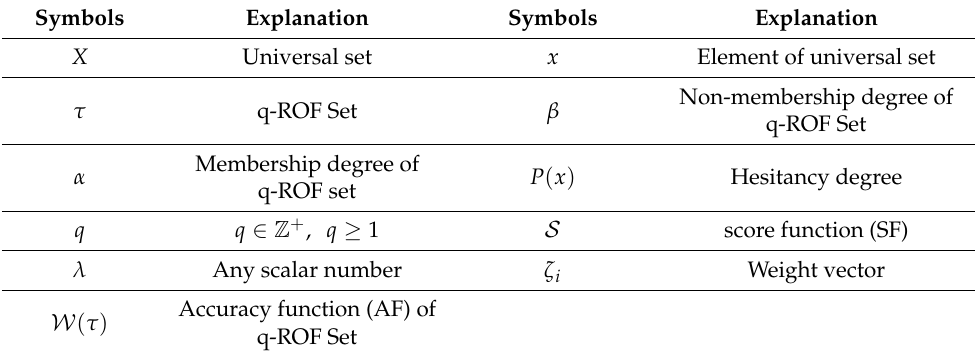
Table 1. Explanation of symbols.